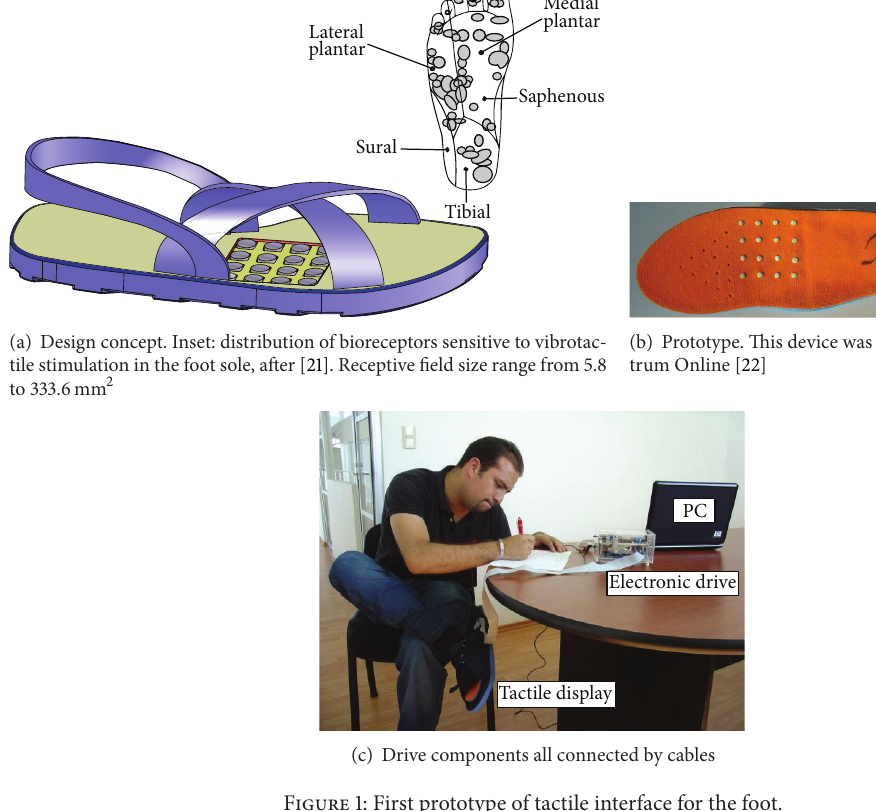
Figure 1: First prototype of tactile interface for the foot.